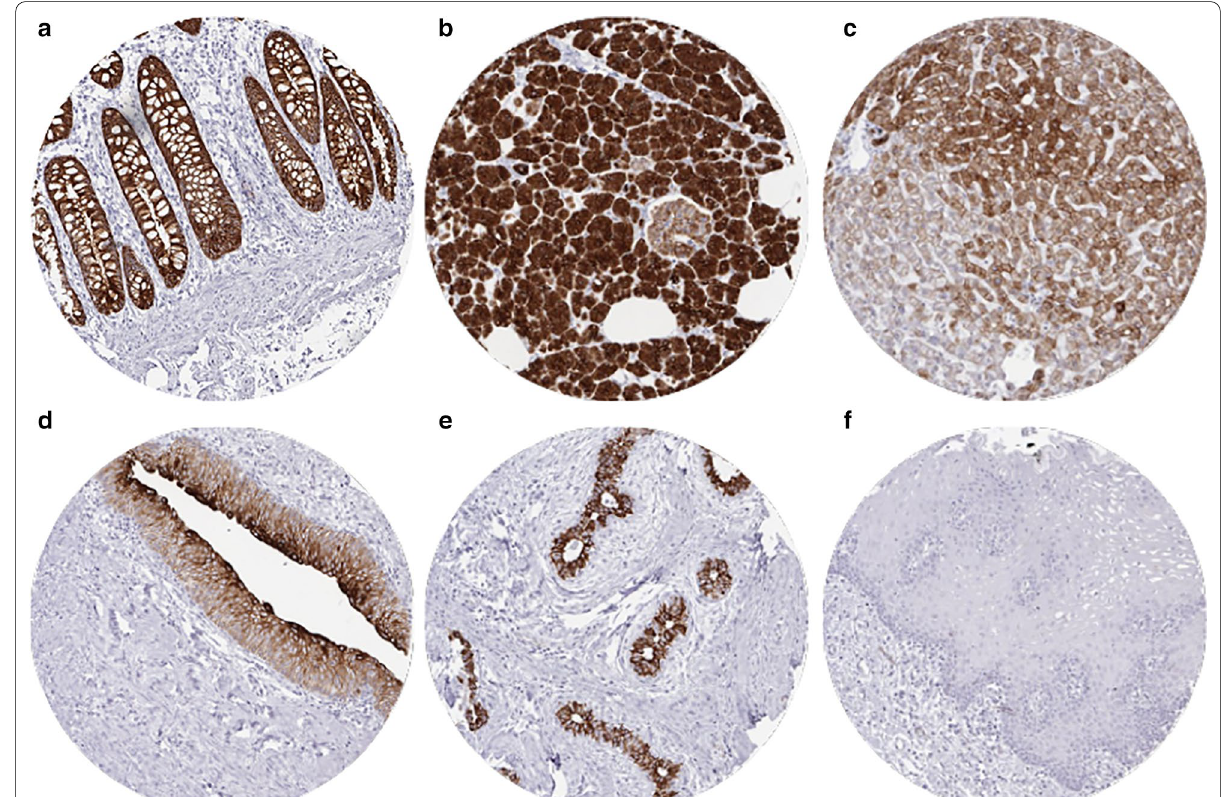
Fig. 1 Cytokeratin 18 (CK18) expression in normal tissues. The images show strong CK18 staining in epithelial cells from rectum ( a ) and pancreas ( b ), a zonal staining variability in the liver ( c ), strongly positive umbrella cells and a gradually decreasing staining intensity from superficial to basal urothelial cells in the bladder ( d ), strong positivity in acinus cells but absent staining in basal cells of the breast epithelium ( e ) and a complete lack of staining in squamous epithelium of the oral mucosa ( f